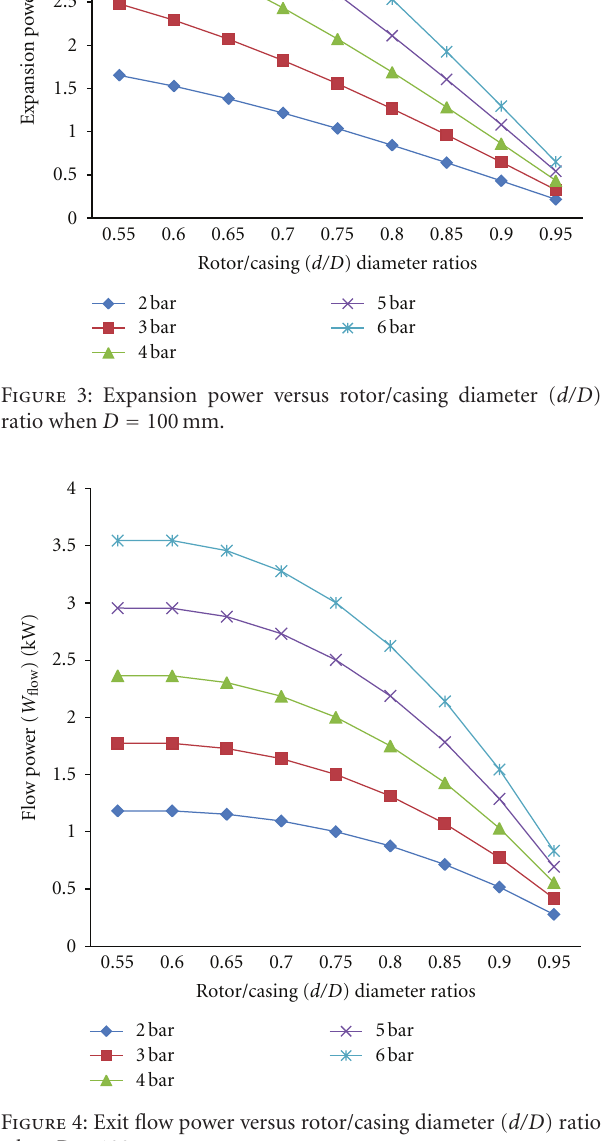
Figure 6: Percentage contribution of exit flow power versus rotor/ casing diameter ( d/D ) ratio when D = 100